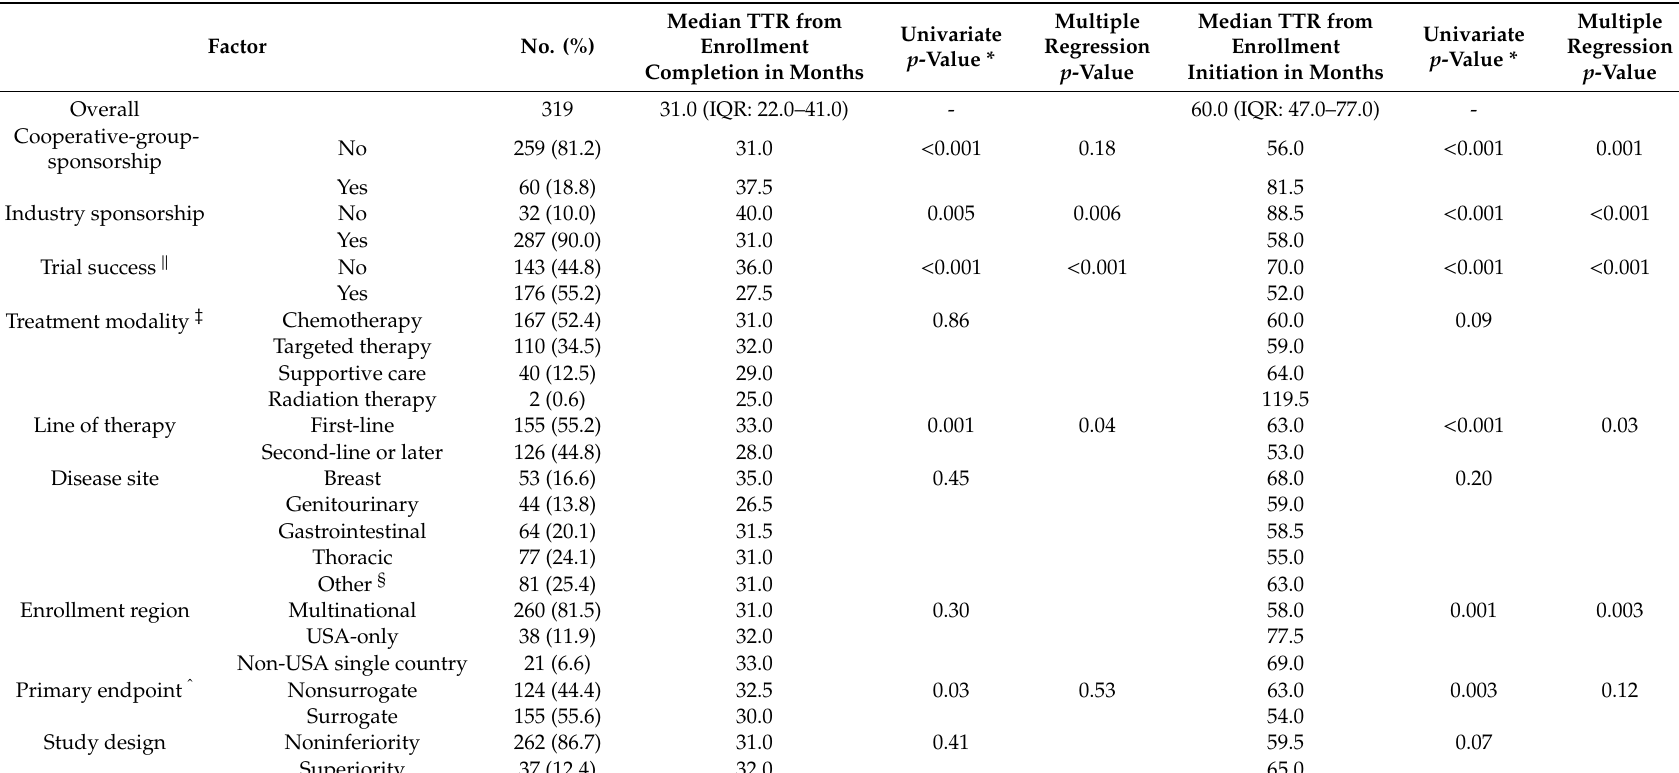
Table 1. Factors associated with time to reporting (TTR) from enrollment completion and initiation. Univariate and multiple regression